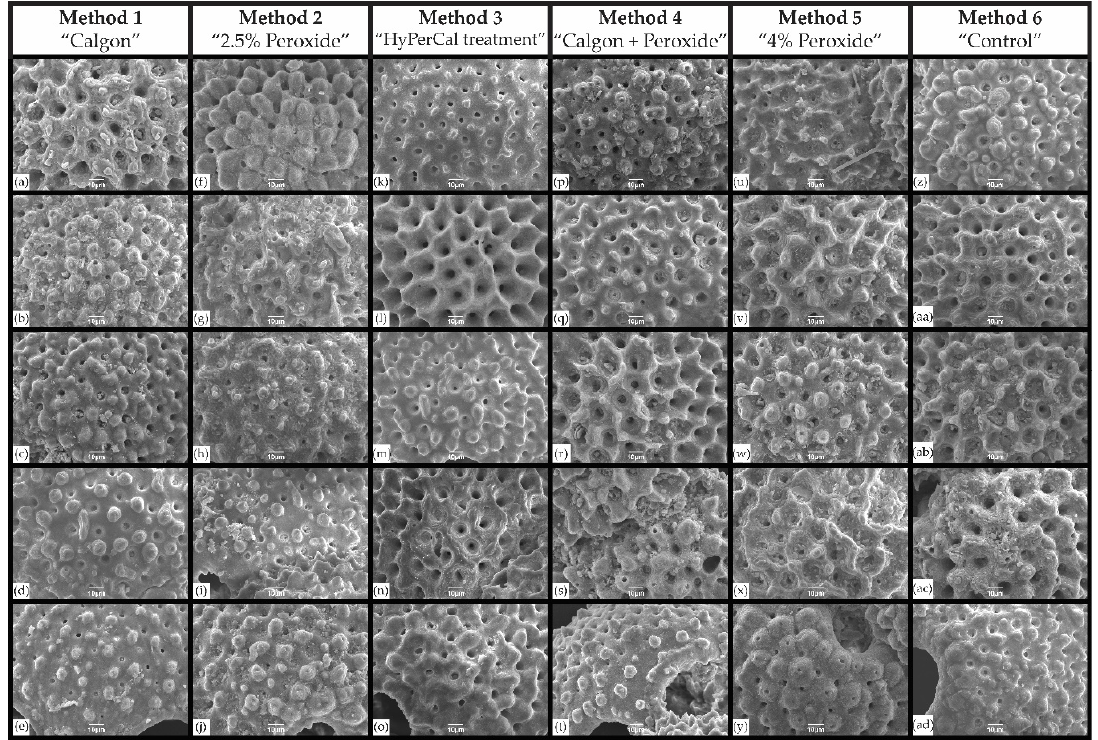
Figure 2. Scanning electron microscope images of the ultrastructure of the specimens after their treatment with the different cleaning methods: ( a – e ) tomographs of specimens after treatment with Na 6 O 18 P 6 , ( f – j ) images of specimens after treatment with 2.5% H 2 O 2 solution; ( k – o ) images after treatment first with 2.5% H 2 O 2 and subsequently with Na 6 O 18 P 6 solution (HyPerCal); ( p – t ) images after treatment simultaneously with 2.5% H 2 O 2 and Na 6 O 18 P 6 solution; ( u – y ) images after treatment with 4% H 2 O 2 , and ( z – ad ) images after treatment with only with distilled water.